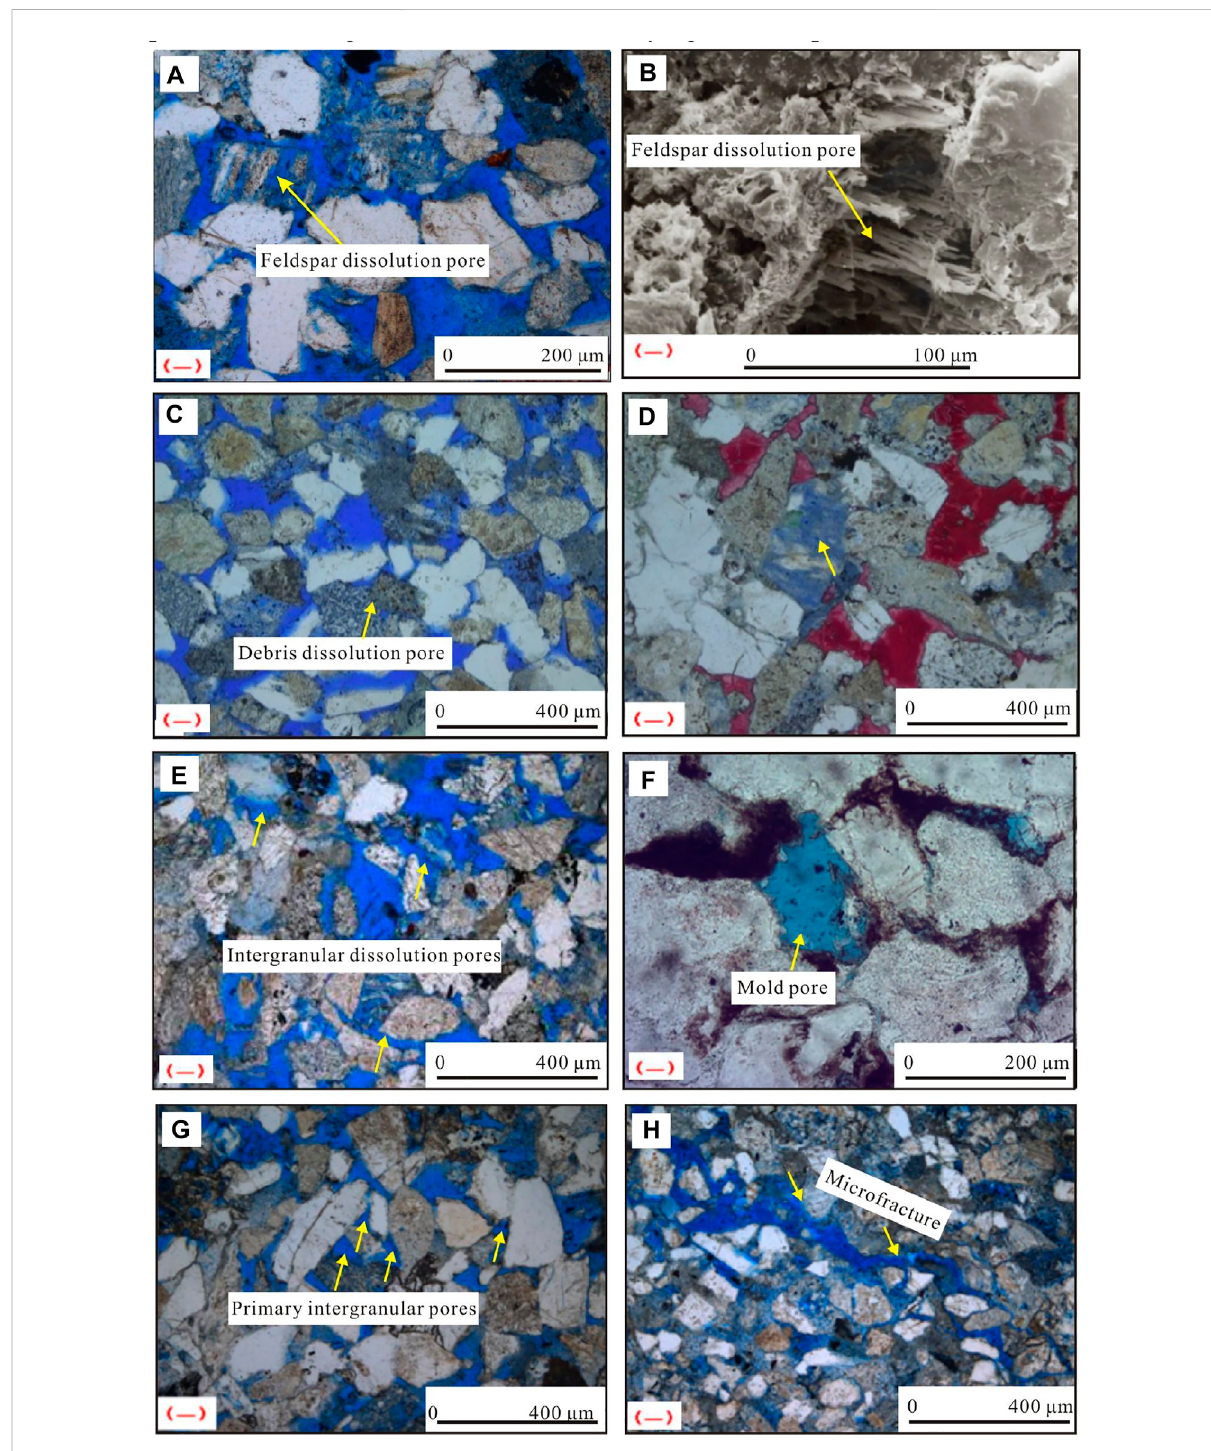
FIGURE 7 Development characteristics of pores in the sandstone of the target layer. Notes: (A) Feldspar dissolution pores, Jian 25 well, 460.24m; (B) Feldspar dissolution pore, Ji 41 well, 1369.76m; (C) Detritus dissolution pores, Jian 24 well,495.4m; (D) Debris dissolution pores, Ji+28 – 15.1 well, 1324.42m; (E) Fine feldspar debris-siltstone, well developed pores, Jian 30 well, 370.0m; (F) Mould pores, Ji +28 – 015.1 well, 1364.75m; (G) Primary pores, Jian 30 well, 458.1m; (H) Fine feldspar debris-siltstone, micro-fractures, Jian 25 well,